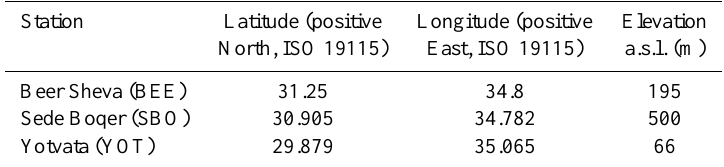
Table 1. Geographical coordinates of the three stations. Period is 2006–2011. All data are coincident. Number of samples is 19849 in G , B and D .